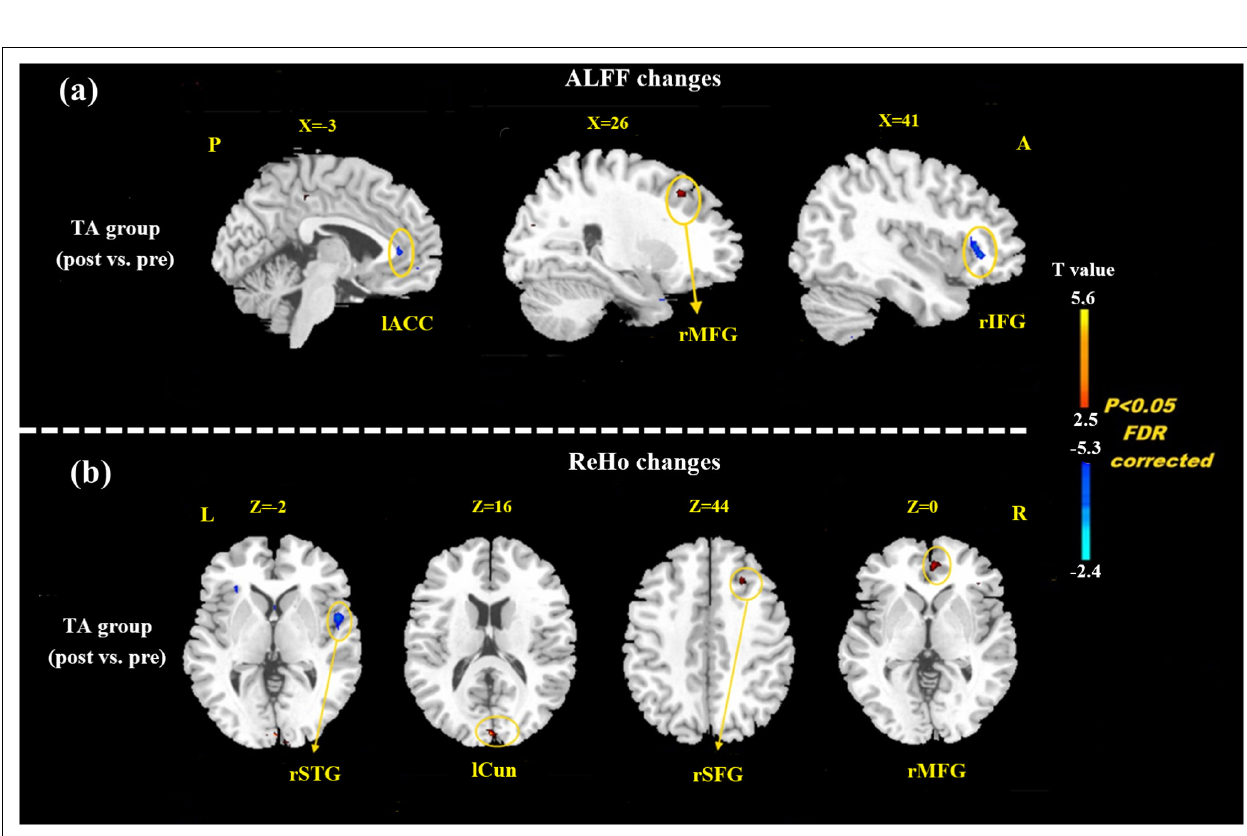
FIGURE 3 | Resting state ALFF and ReHo changes of MMoA patients in true acupuncture group ( p < 0.05, FDR corrected). (a) Brain regions showed altered ALFF value in MMoA patients after true acupuncture treatment. (b) Brain regions showed altered ReHo value in MMoA patients after true acupuncture treatment. Warm colors indicate ALFF and ReHo increases after true acupuncture group; cool colors indicate ALFF and ReHo decreases after true acupuncture group. A, anterior; ACC, anterior cingulate; Cun, cuneus; IFG, inferior frontal gyrus; L, left; MFG, middle frontal gyrus; P, posterior; R, right; SFG, superior frontal gyrus; STG, superior temporal gyrus; TA, true